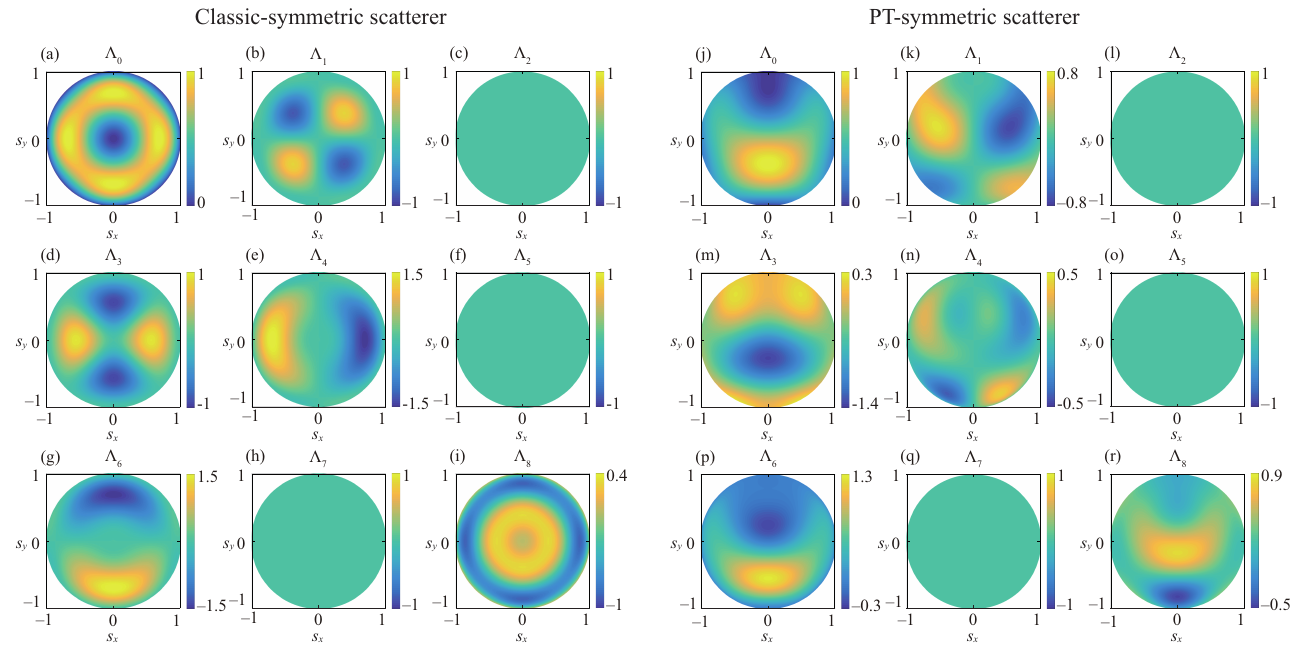
Figure 3. Simulation results for the nine generalized Stokes parameters of the far-zone scattered field by a four-point scatterer having ( a – i ) classic-symmetric potential and ( j – r ) PT-symmetric potential. The incident beam is a partially coherent radially polarized beam with the GSM correlation function. The spatial coherence width ξ 0 = 100/ k .